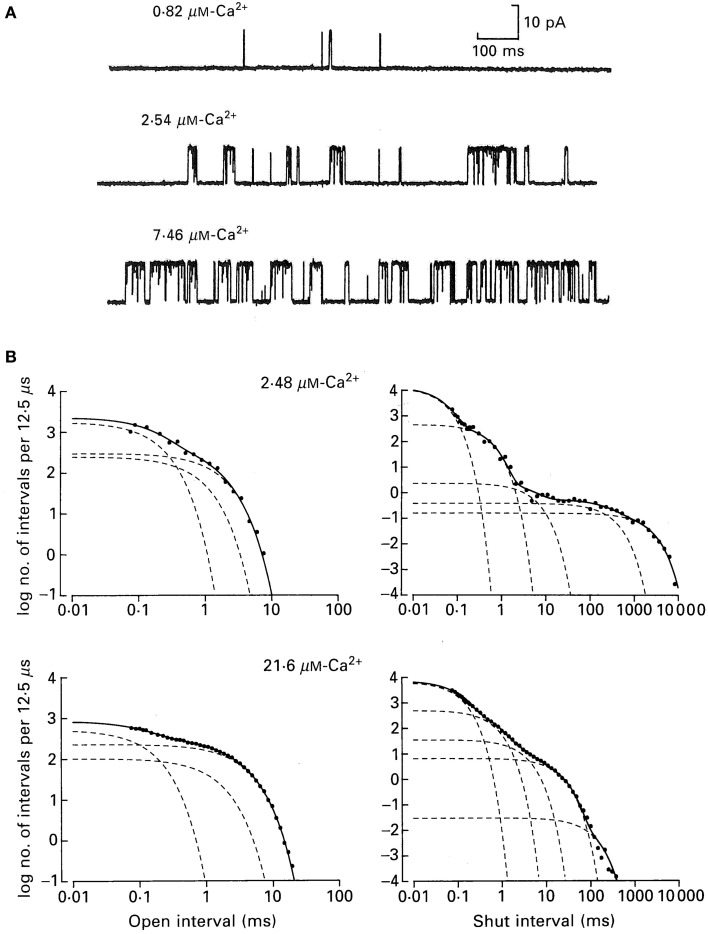
A BK channel gating in a minimum of three open and five closed states. (A) Single channel records at the indicated Ca2+. Opening is upward. (B) Open and closed dwell-time distributions at the indicated Ca2+ plotted on log–log coordinates for a different channel than those in part A. The open distributions were described by the sums of three significant open exponentials (dashed lines summing to make the continuous lines through the data), and the closed distributions were described by the sums of five significant closed exponentials from McManus and Magleby (1991).